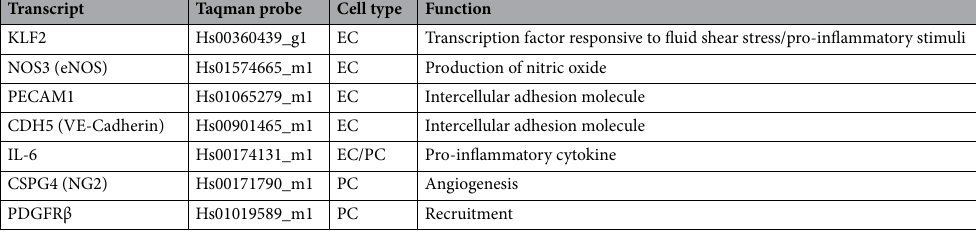
Table 1. List of genes and probes used. EC endothelial cell; PC